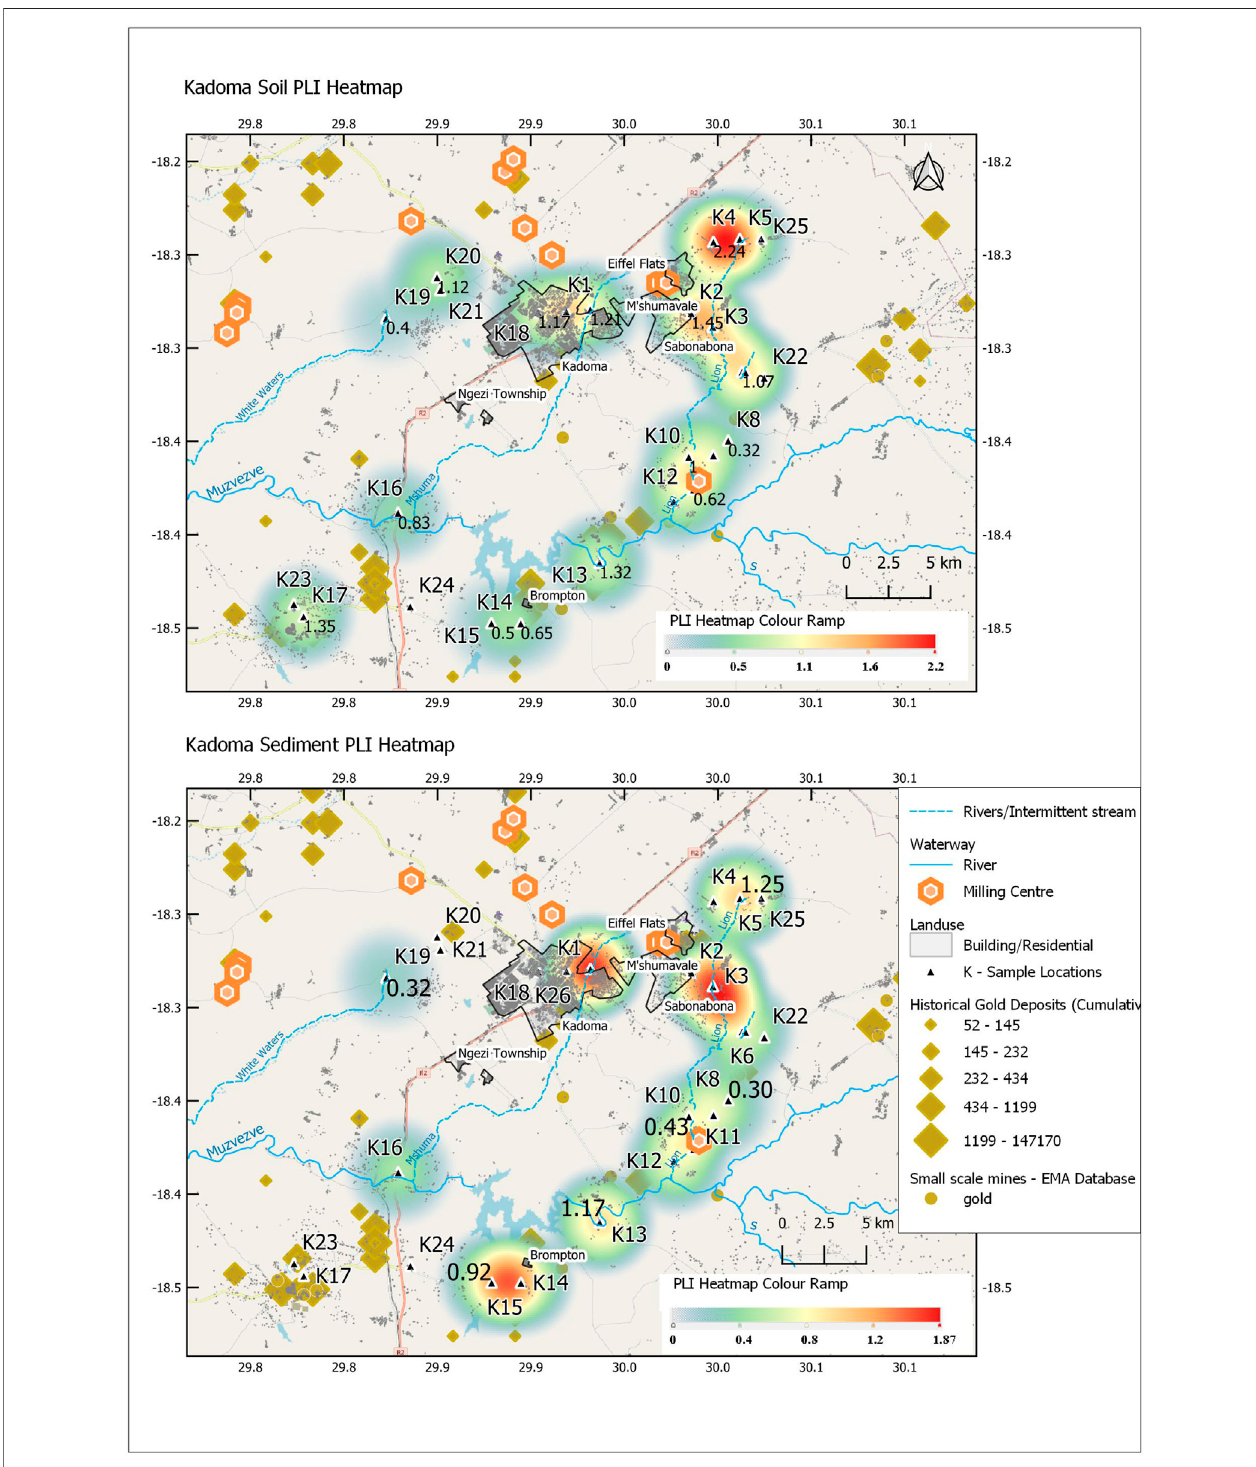
FIGURE 5| Heat map of the PLI values for the total PHEs in soil (above) and sediment (bottom) samples at the KAD site. The red colour ramp wasused to indicate the intensity of the PLI and the PLI levels at each location are highlighted in yellow. K* represents the sample location ID.